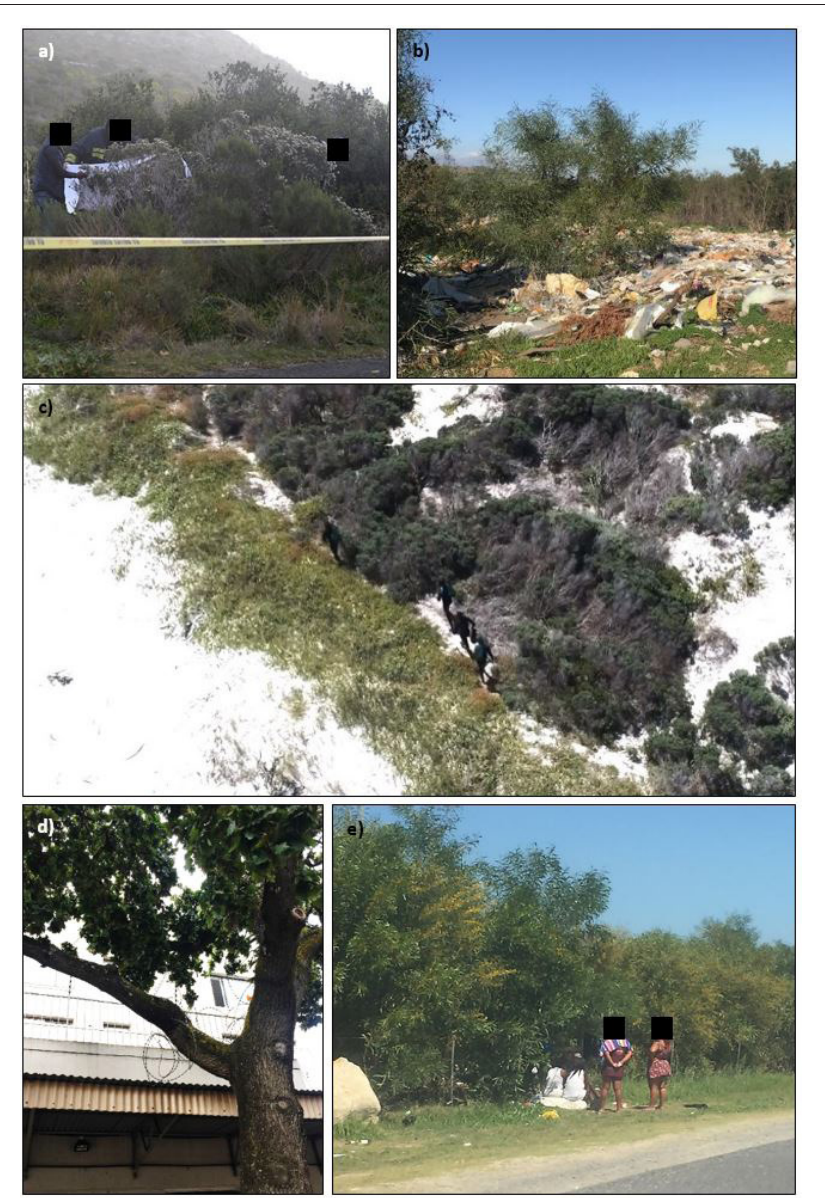
Figure 5. Examples of vegetation associated with criminal activity. (a) The scene of a violent crime incident where the victim’s body was discovered in dense native fynbos vegetation (Photo: L. Knipe); (b) Illegal dumping of waste in dense Acacia saligna stands (Photo: L.J. Potgieter); (c) Abalone poachers hide their catch in native fynbos vegetation (Photo: W. Witte); (d) The alien tree Quercus robur L. (Fagaceae) used to gain access to a first-floor parking lot where vehicles are regularly broken into (Photo: L.J. Potgieter); (e) Acacia saligna stands are used as cover for prostitution (Photo: L.J.